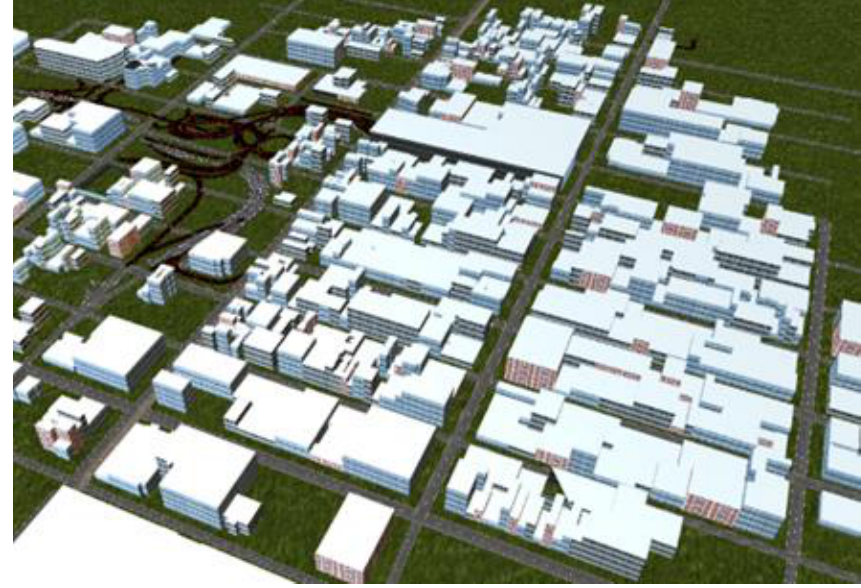
Figure 2. Project Vision Support Framework Components.